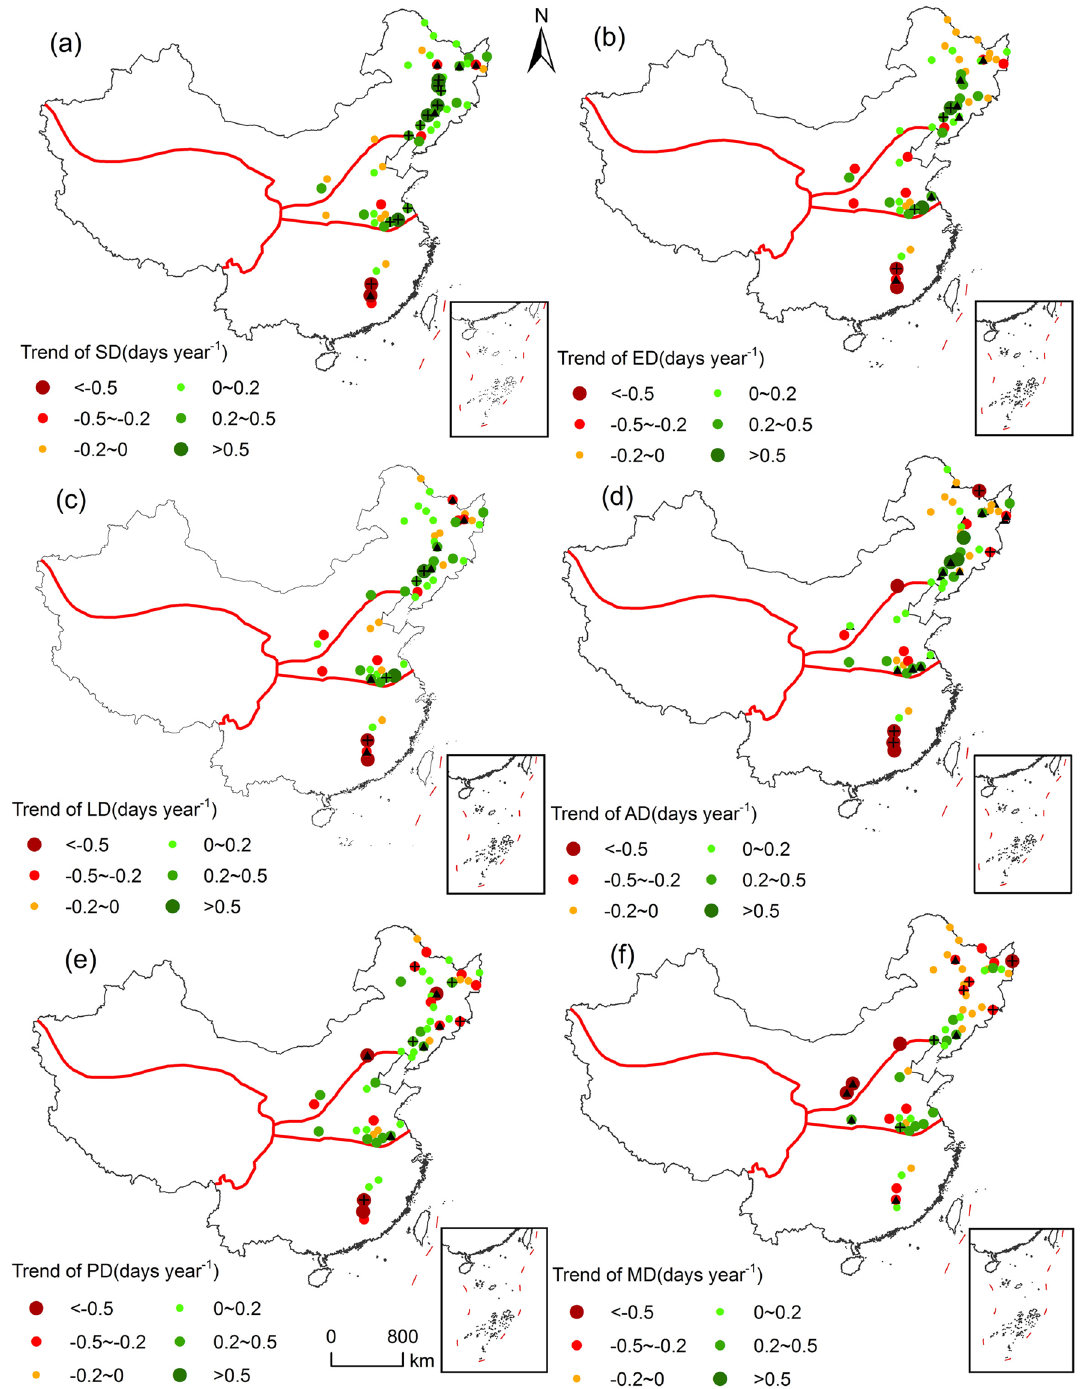
Figure 2. Distribution of different soybean phenological stage trends from 1992 to 2018 in China. ( a )–( f ) Represent SD, emergence date (ED), trifoliate period (LD), anthesis date (AD), podding date (PD), and maturity date (MD), respectively. The abbreviations are the same as in Fig. 1. The map was generated by ArcGIS 10.2 software (https:// www. esri. trifoliate period (72.55% stations) to average temperature were positive, whereas those of anthesis date (56.86% stations), podding date (58.82% stations) and maturity date (66.67% stations) were negative. As 1 ℃ increase in average temperature, the SD, emergence date, and trifoliate period of soybean delayed by 0.37 ± 0.2, 0.68 ± 0.19, and 0.59 ± 0.2 days, while the anthesis date, podding date and maturity date were advanced by − 0.11 ± 0.19, − 0.29 ± 0.18, and − 0.6 ± 0.14 days, respectively (Fig. 5a). Moreover, the key growth periods of soybean were all negatively sensitive to average temperature. The negative temperature sensitivity of whole growth period